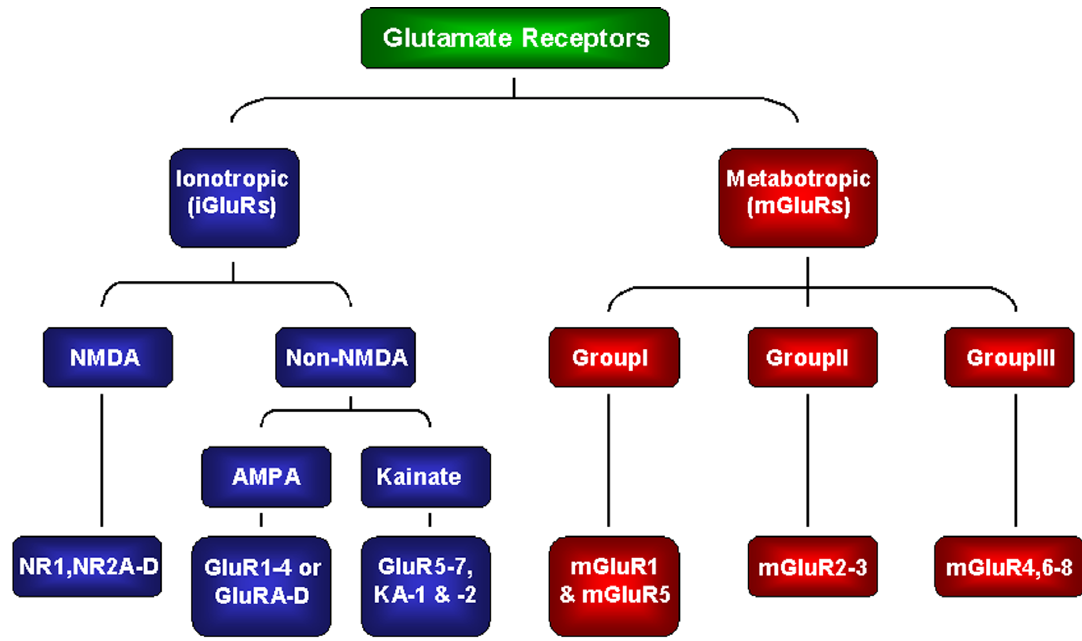
FIGURE 1. Schematic illustrating the relationships between members of the glutamate receptor